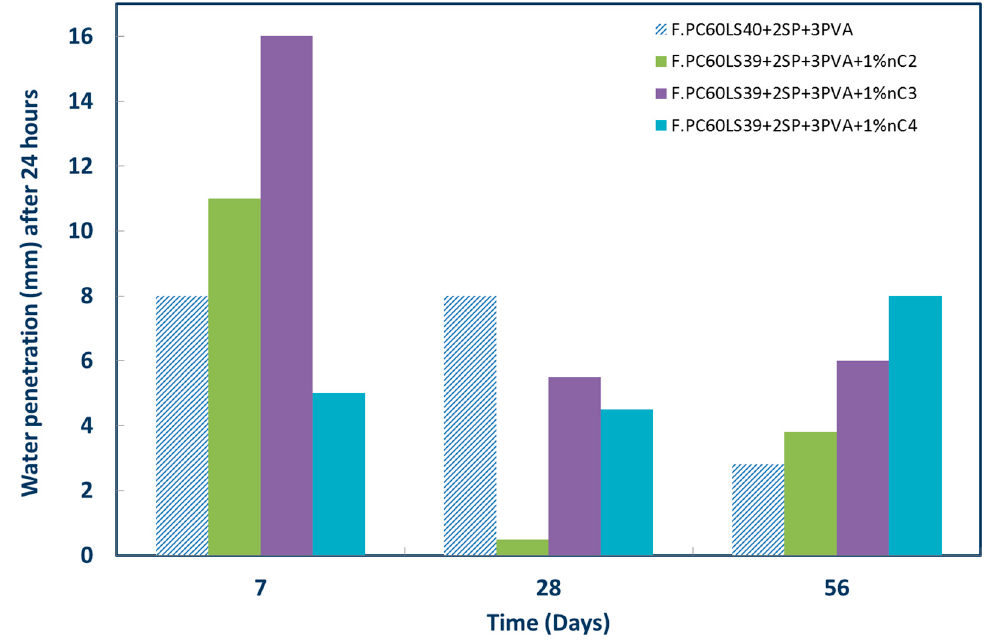
Figure 12. Effect of nMt type (at 1% dosage) on the impermeability of fiber–cement nanohybrids based on F.PC60LS40PVA3SP2.